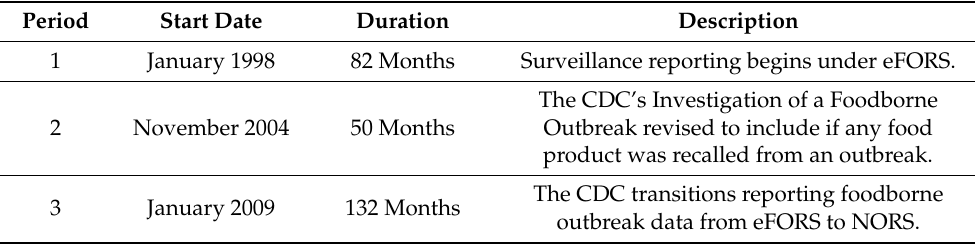
Table 1. Critical periods used to examine trends and seasonality of CDC foodborne and waterborne outbreak surveillance records with segmented regression